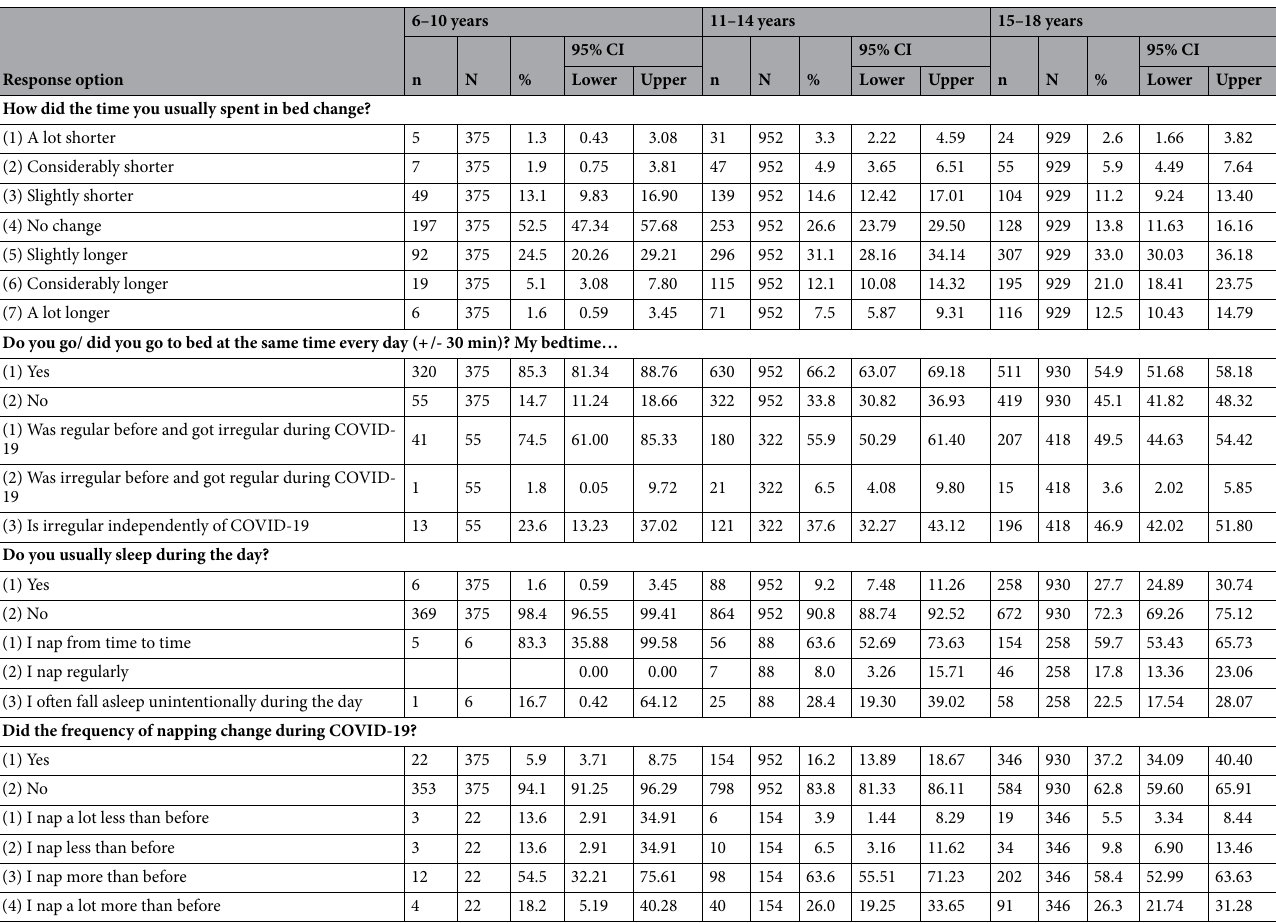
Table 3. Changes in time spent in bed, regularity of bedtimes and daytime sleep/napping. CI 95% confidence interval with lower and upper border, empty spaces response option was not chosen in this age